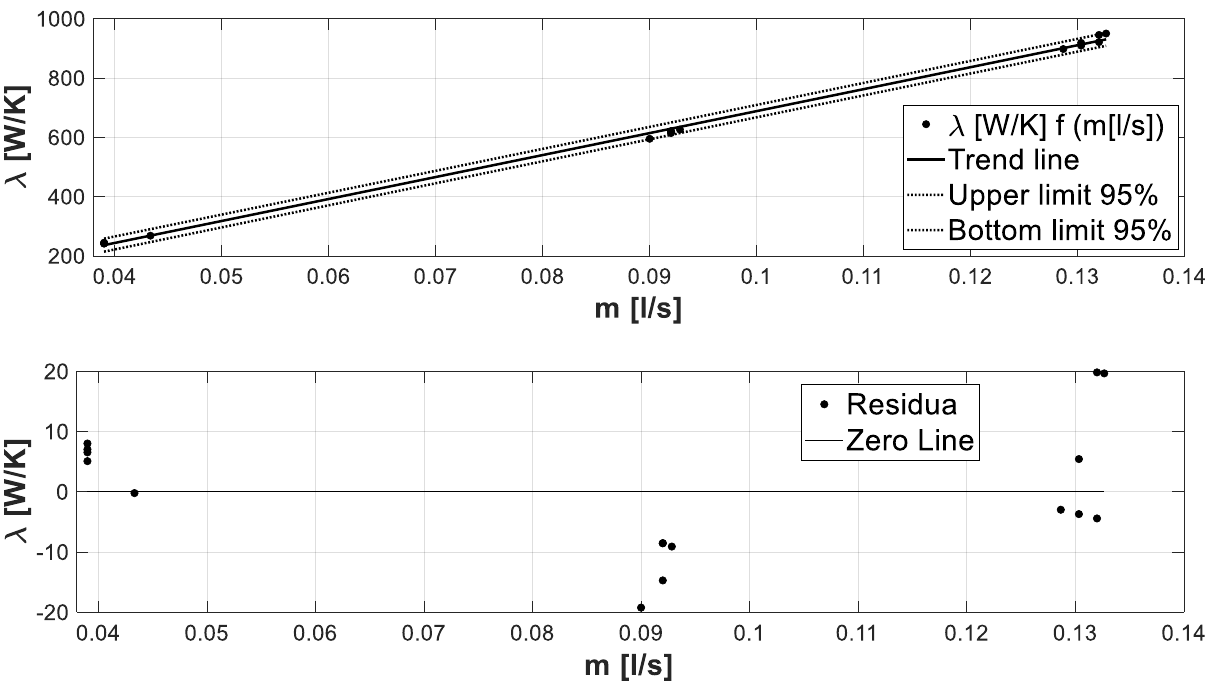
Figure 12. Impact of the circulator pump output on the value of the thermal conductivity coefficient.